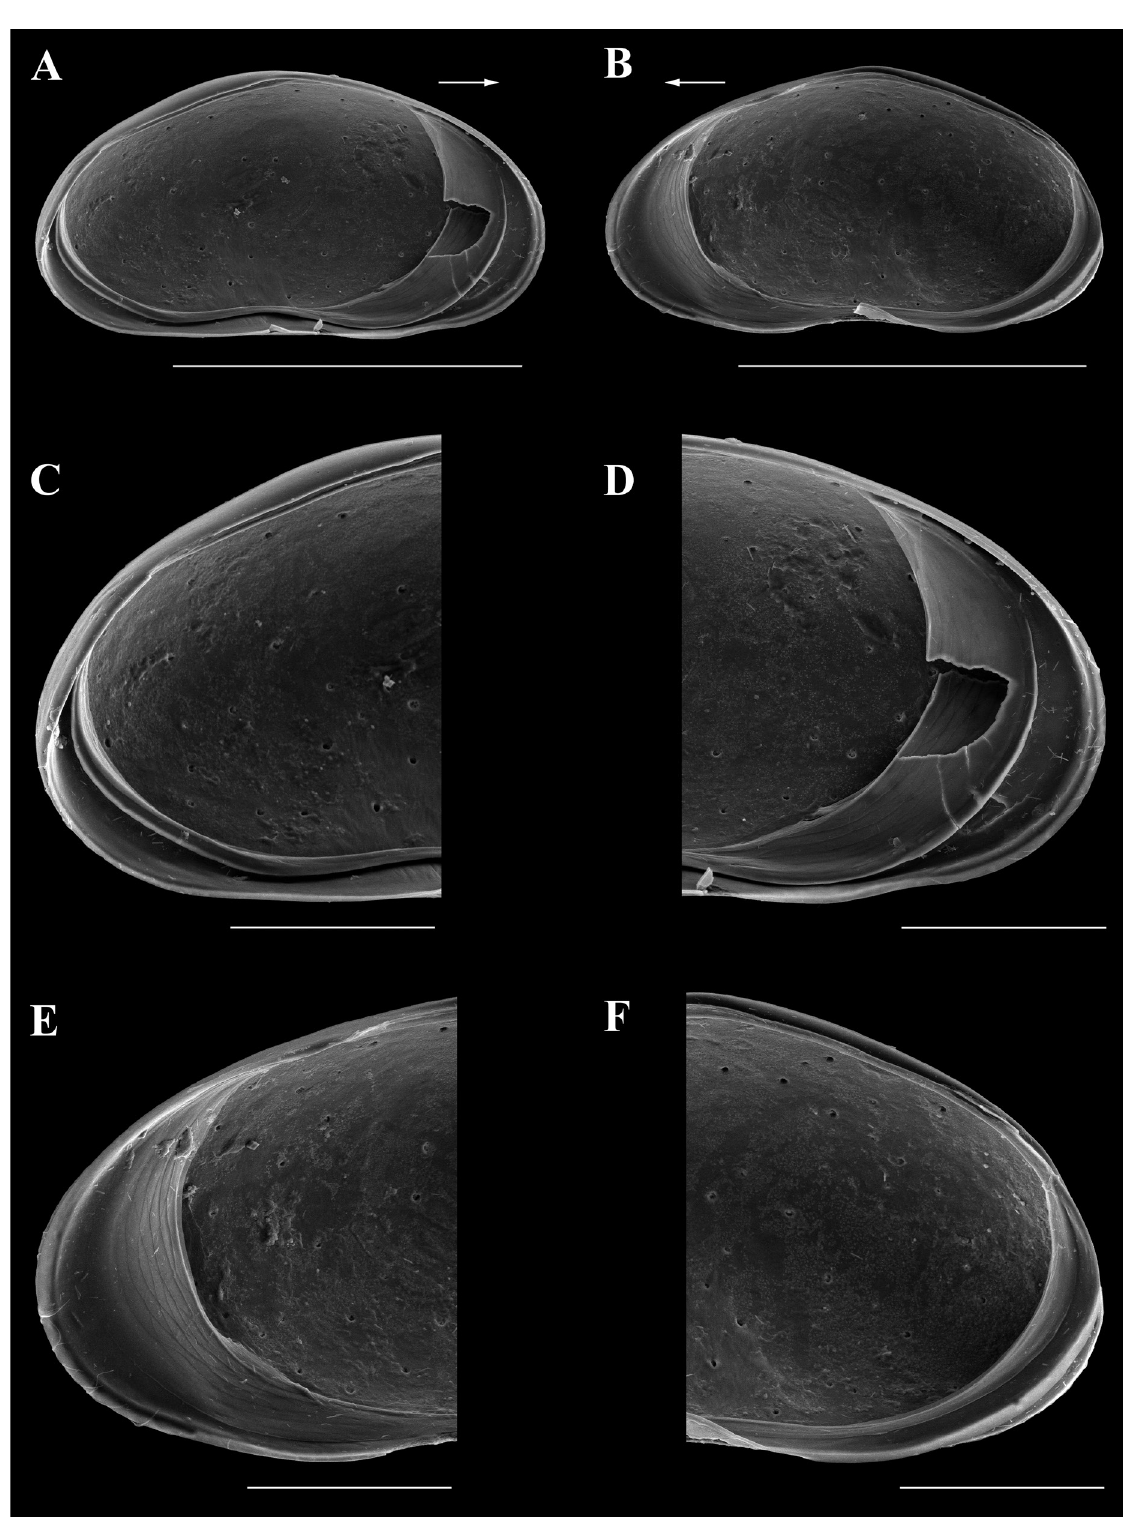
Fig. 7. Brasilodopsis baiabonita gen. et sp. nov. from Bonito, State of Mato Grosso do Sul, ♀. A . LVi (MZUSP 41826). B . RVi (MZUSP 41826). C . LVi, detail of posterior part (MZUSP 41826). D . LVi, detail of anterior part (MZUSP 41826). E . RVi, detail of anterior part (MZUSP 41826). F . RVi, detail of posterior part (MZUSP 41826). Scale bars: A–B = 300 µm; C–F = 100